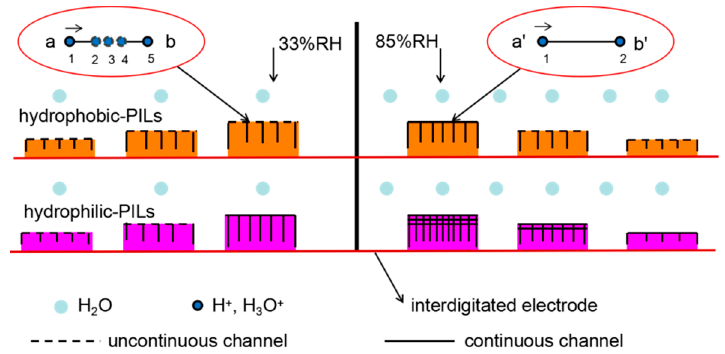
Figure 10. Schematic illustration of the humidity sensing mechanism for a PIL film with varying thickness and anion type.